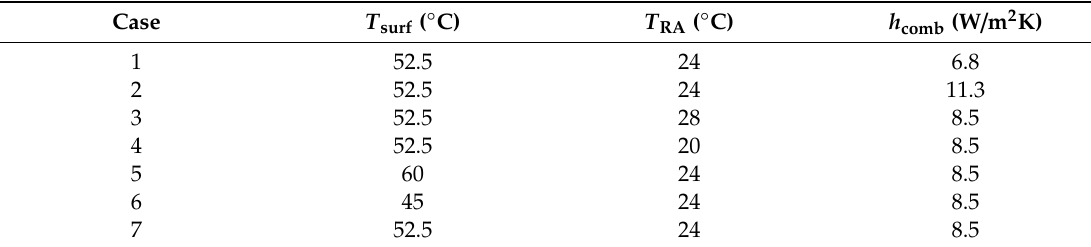
Table 7. Experiments cases for model validation.